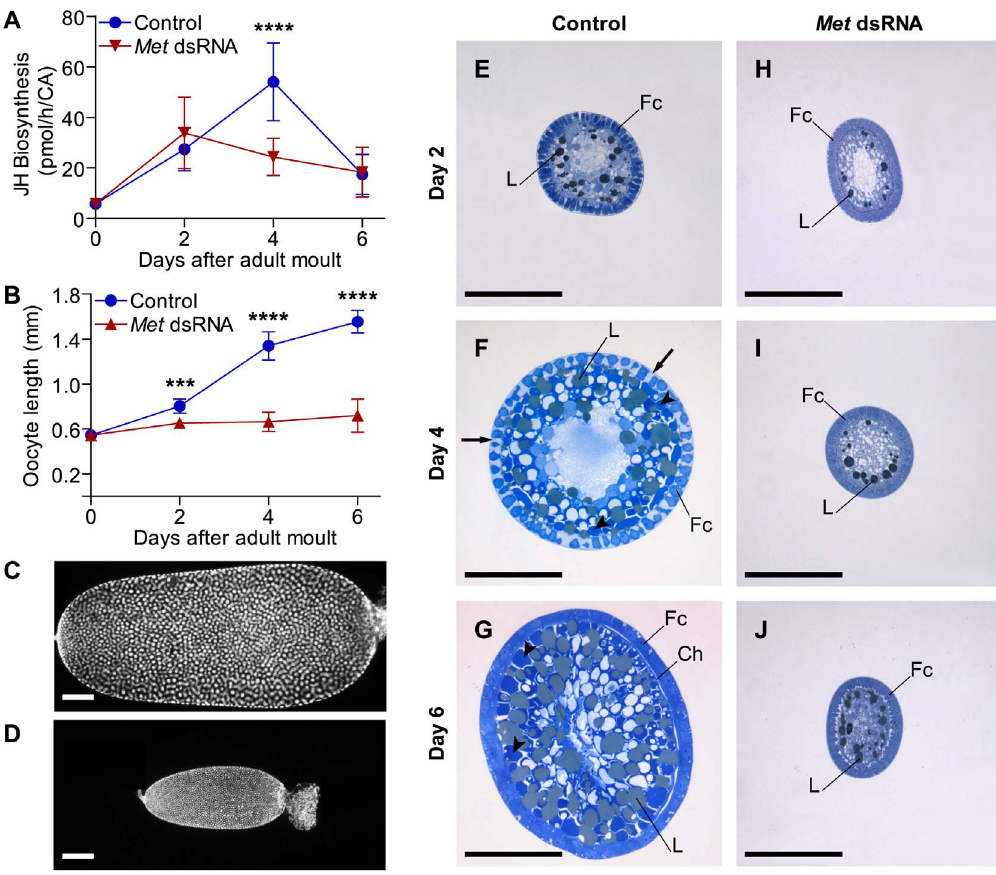
Figure 4. Oocyte growth and JH biosynthesis are inhibited as a consequence of DippuMet dsRNA treatment. JH biosynthesis for individual corpus allatum (A) and length of basal oocytes (B) dissected during first gonadotropic cycle of mated female D. punctata injected with either control (blue circles) or Met dsRNA (red triangles). Vertical bars indicate SEM, N=8–20. C – D , difference in overall size of 6-day-old basal oocyte from control (C) versus Met dsRNA (D) treated animals, follicle cell nuclei are stained with DAPI. E – J , transverse sections of basal oocytes showing follicle cells (Fc), intercellular gaps (arrows), yolk spheres (arrowheads), lipid spheres (L) and chorion (Ch). Scale bars indicate 200 m m.